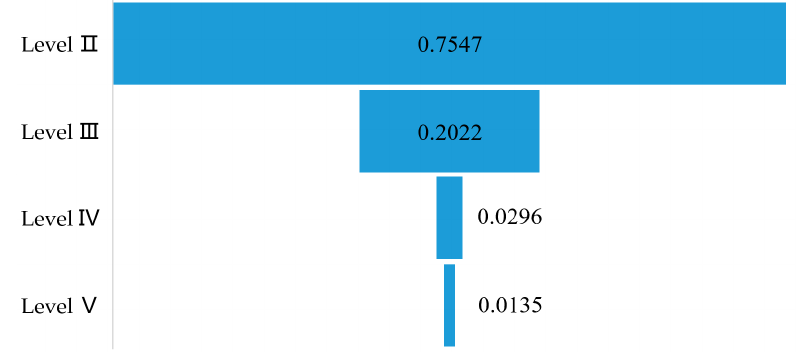
Figure 1. The occurrence probabilities of 371 hazmat transportation accidents (HTAs), with levels classified according to the casualties or economic losses caused by accidents.